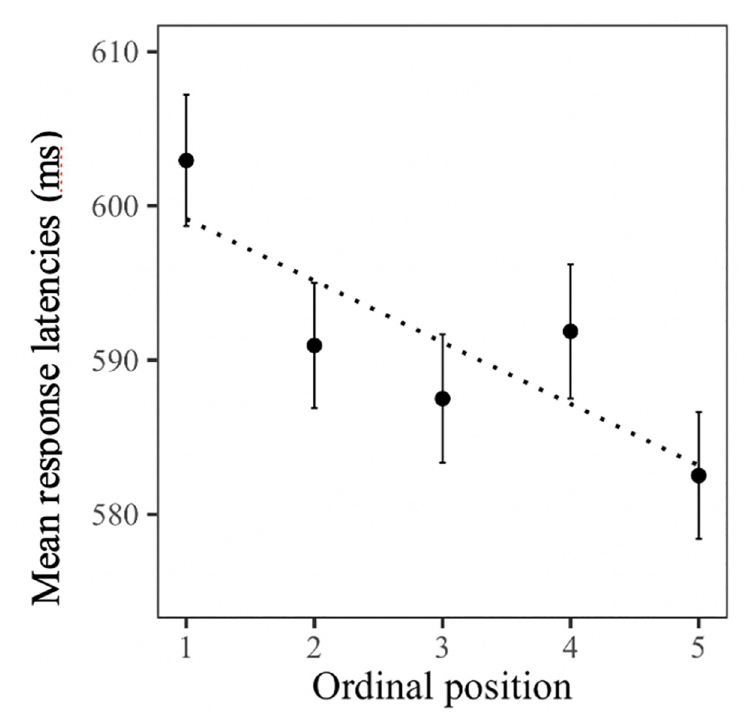
Fig 3. Mean reaction times (response latency) and standard error (in milliseconds) observed in Experiment 2 broken down by ordinal position.